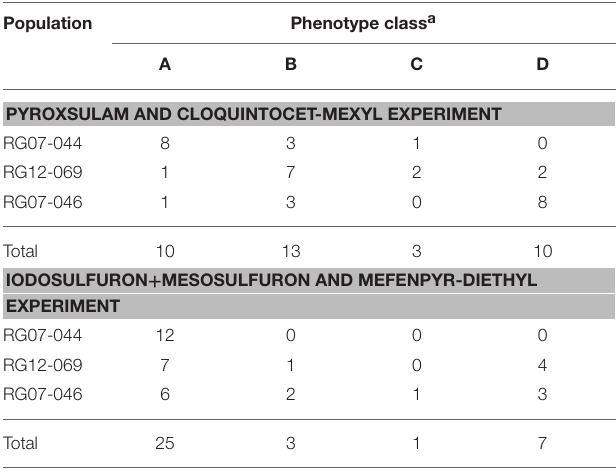
TABLE 2 | Assignation to phenotype classes of the rye-grass plants used to assess the effect of safeners on the sensitivity of individual plants to the associated